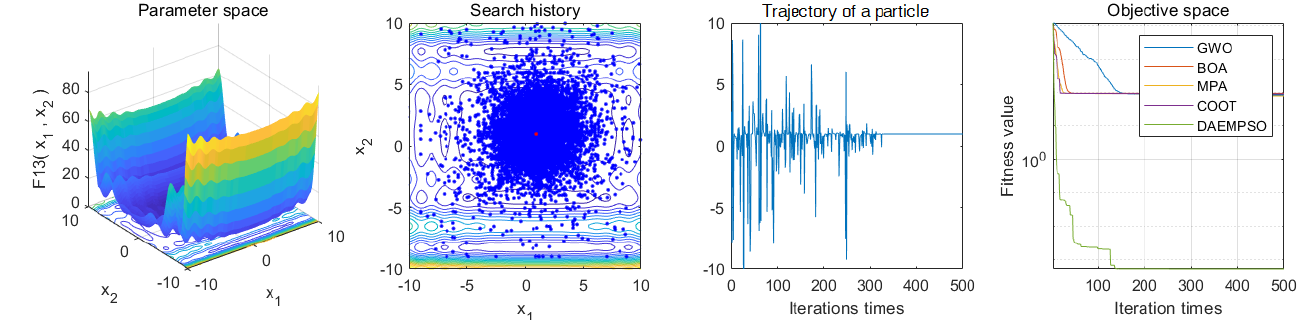
Figure 6. Convergence curves of five optimization algorithms for function (1000-dimension) F1 – F13.